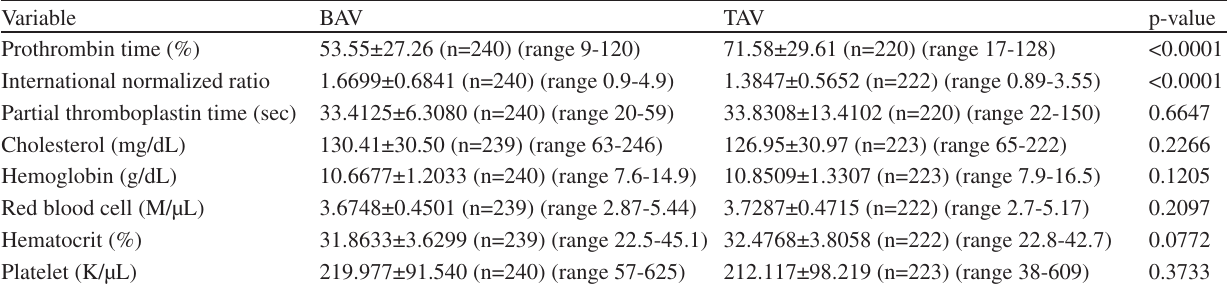
Table 5 - Laboratory findings of patients undergoing aortic valve